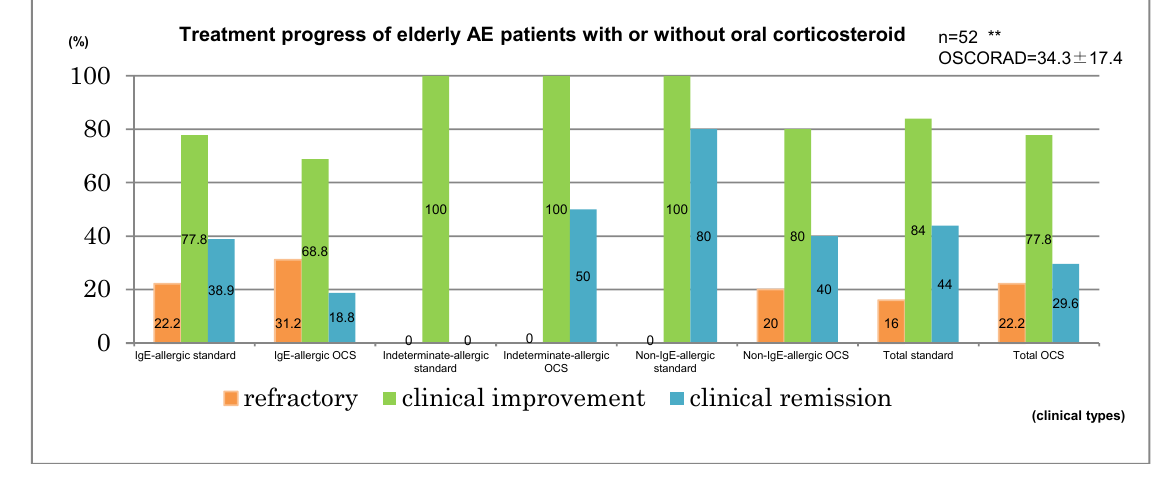
Figure 6. Treatment progress of elderly patients with atopic eczema. * IgE-allergic: n = 34, OSCORAD = 38.5 ± 17.6; Indeterminate-allergic: n = 8, OSCORAD = 24.1 ± 7.8; Non-IgE-allergic: n = 10, OSCORAD = 28.5 ± 18.2. ** IgE-allergic standard: n = 18, OSCORAD = 35.7 ± 16.3; IgE-allergic OCS: n = 16, OSCORAD = 41.6 ± 19.1; Indeterminate-allergic standard: n = 2, OSCORAD = 28.7 ± 6.4;